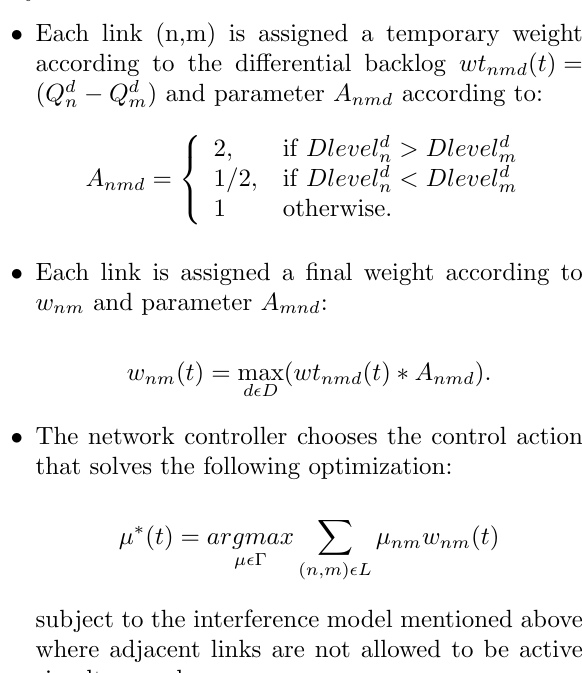
Figure 2. An example of the L ay BP execution.